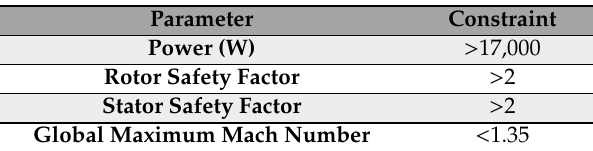
Table 1. Final design